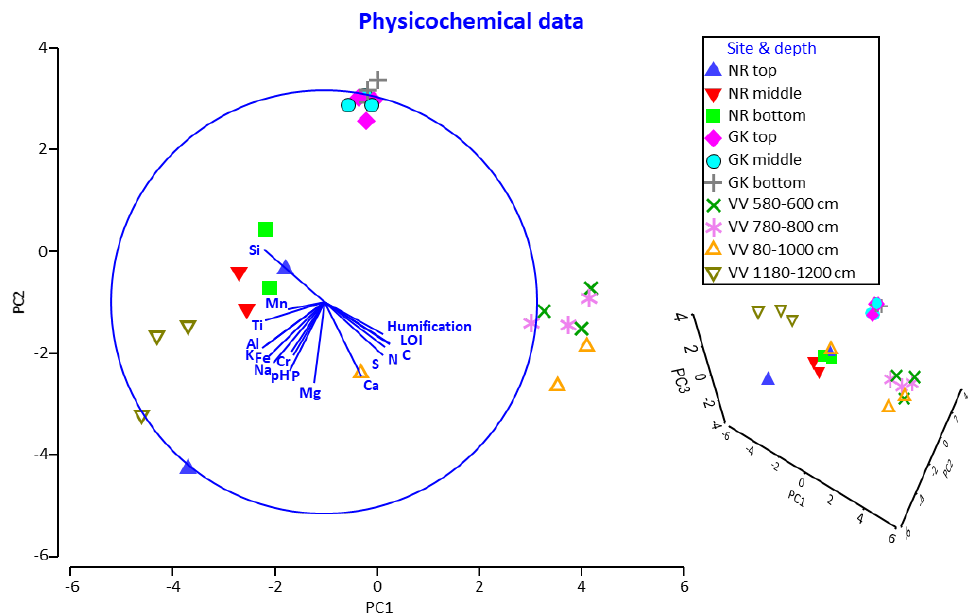
Figure 8. Two-dimensional and three-dimensional (insert bottom right) principal component analysis plots of normalized physicochemical data from the peat samples; 47.1%, 32.0% and 9.3% (cumulative 88.4%) of the variations are explained by PC1, PC2, and PC3, respectively. NR = Nuwejaars River system (developing peatland); GK = Goukou River system (impacted peatland); VV = Vankervelsvlei (undisturbed peatland). Top: samples from 0 to 5 cm depth; middle: samples from 25 cm depth; bottom: samples from 50 cm depth.